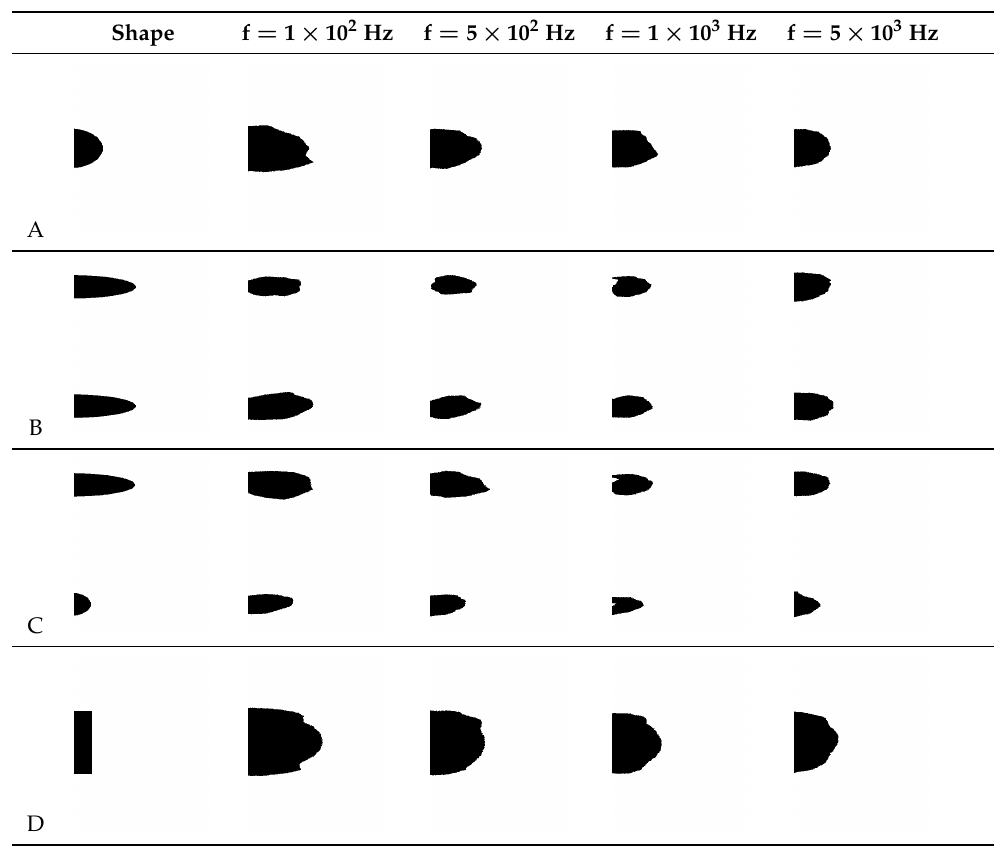
Table 3. One probe with 6 coils, each one of 2 mm height, and each two are spaced by 2.5 mm. We changed the frequency from 100 GHz to 5000